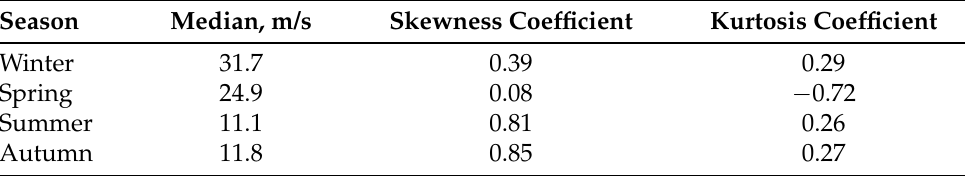
Figure 4. The probability distributions of the wind speed at 175 hPa level at the site of the Hoa Lac observatory. Table 2. Statistics of the wind speed at the 175 hPa at the Hoa Lac